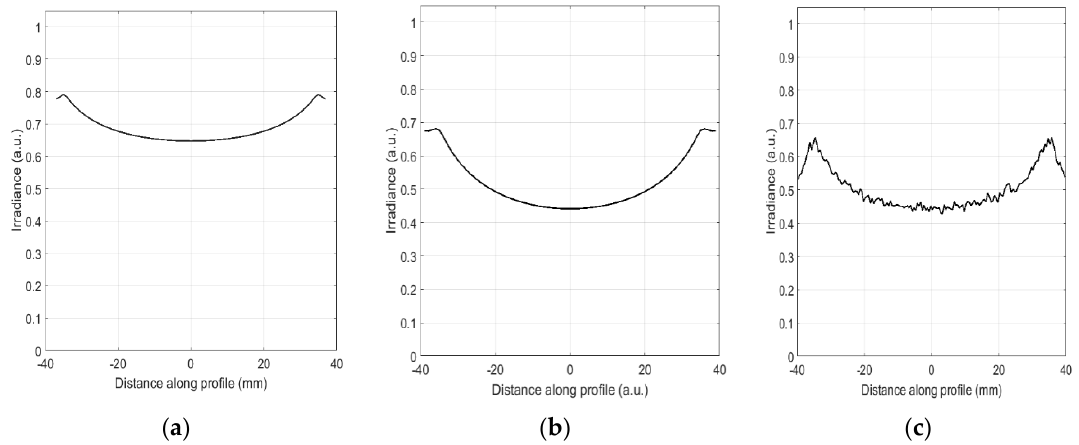
Figure 13. Irradiance pattern and central irradiance profile at the detector for the reflective system, with the detector located at z = 250 mm: ( a ) computed by standard flowline vector potential method; ( b ) computed by OPL correction in flowline vector potential method; ( c ) computed by raytrace.